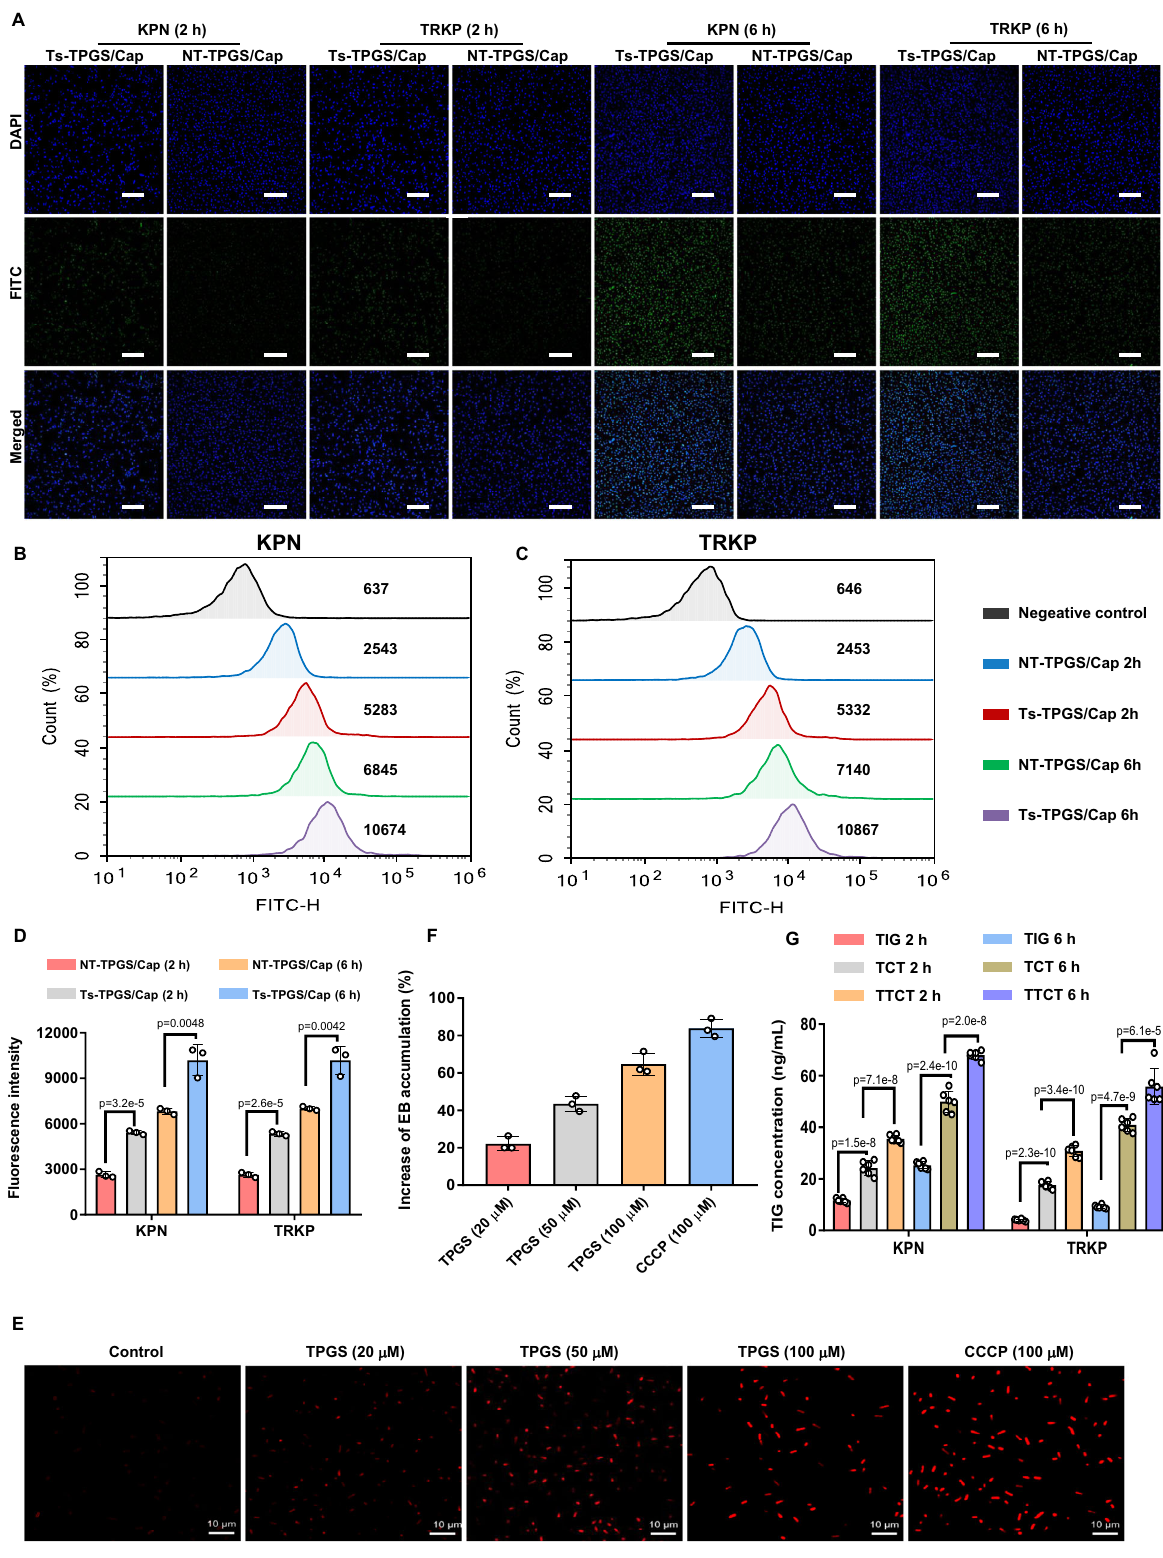
group. Quantitative analysis showed that the increased percen- tages of EB accumulation grew from 22.11 ± 3.67% to 64.75 ± 5.91% as the concentration of TPGS increased from 20 to 100 µM (Fig. 5F), indicating that TPGS treatment manifested an obvious increase in EB accumulation. Similar results were observed in previously reported studies 27